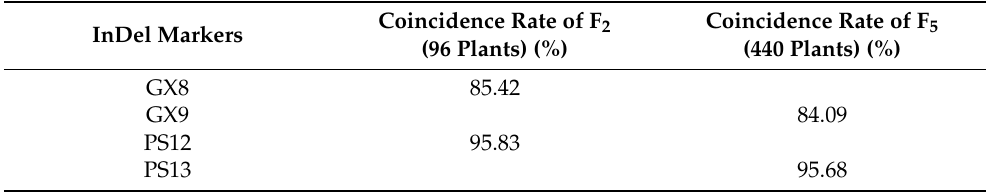
Table 3. Coincidence rate of GX8, GX9, PS12, and PS13 in F 2 (96 plants) and F 5 (440 plants). Coincidence Rate of F InDel Markers